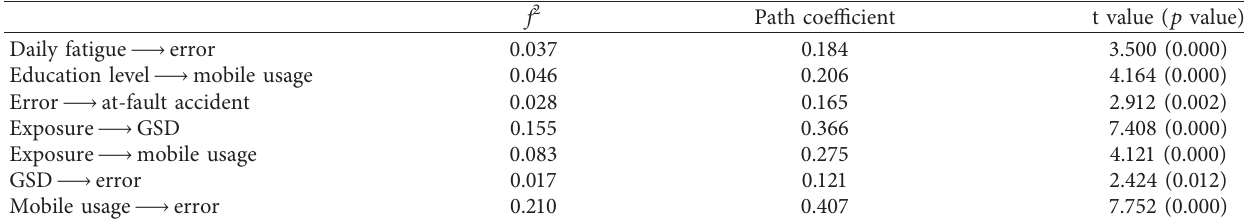
Table 4: f 2 results and path